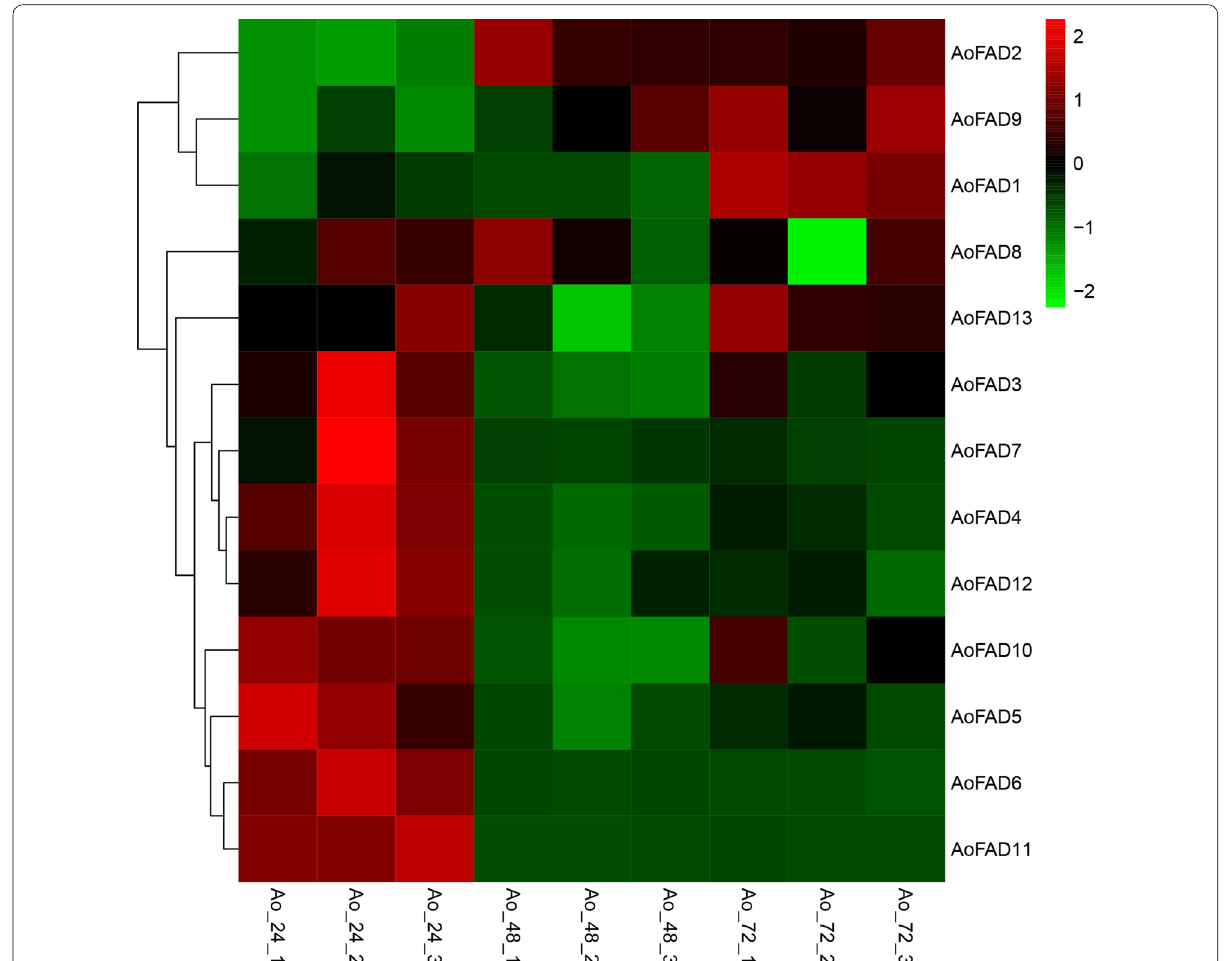
Fig. 4 Expression of the AoFAD genes during growth. Ao_24_1, 2, 3 indicated the three biological reduplicates at 24 h (lag phase). Ao_48_1, 2, 3 indicated the three biological reduplicates at 48 h (logarithmic phase). Ao_72_1, 2, 3 indicated the three biological reduplicates at 72 h (stationary